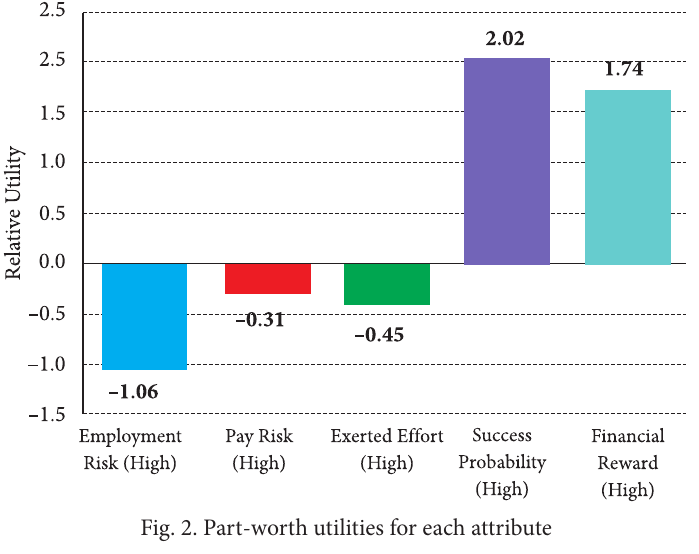
Fig. 2. Part-worth utilities for each attribute